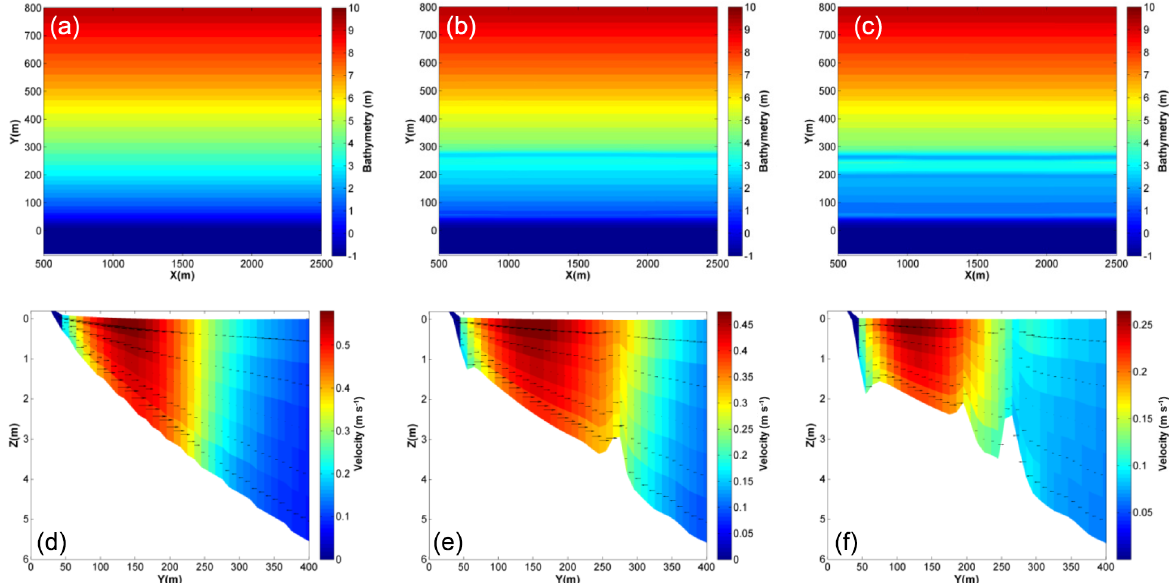
Figure 8. Simulated sandbars for different wave heights. The horizontal plane of the bathymetry (a, b, c) and a vertical cut with velocity modulus and vectors (d, e, f) . (a, d) Initial condition. (b, e) After 45 days of morphological evolution with 1.5m wave height. (c, f) After an additional 45 days of morphological evolution with 1.0m wave height.